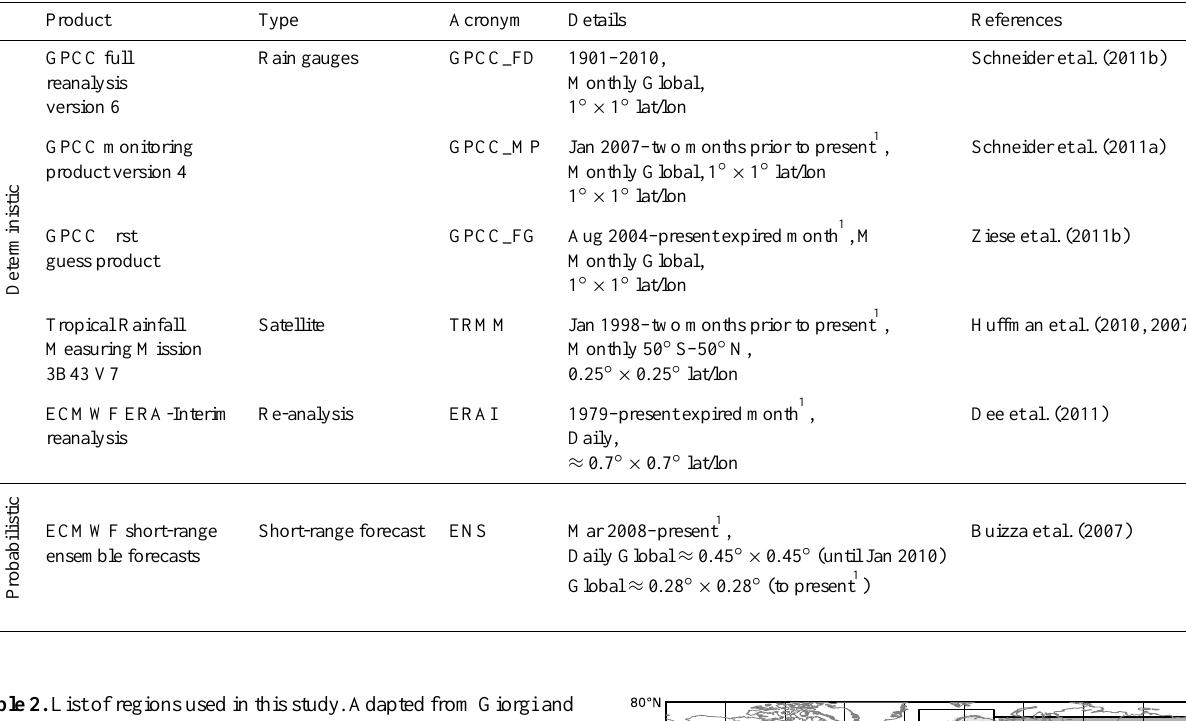
Table 2. List of regions used in this study. Adapted from Giorgi and Francisco (2000) using only land points (see also Fig. 2).